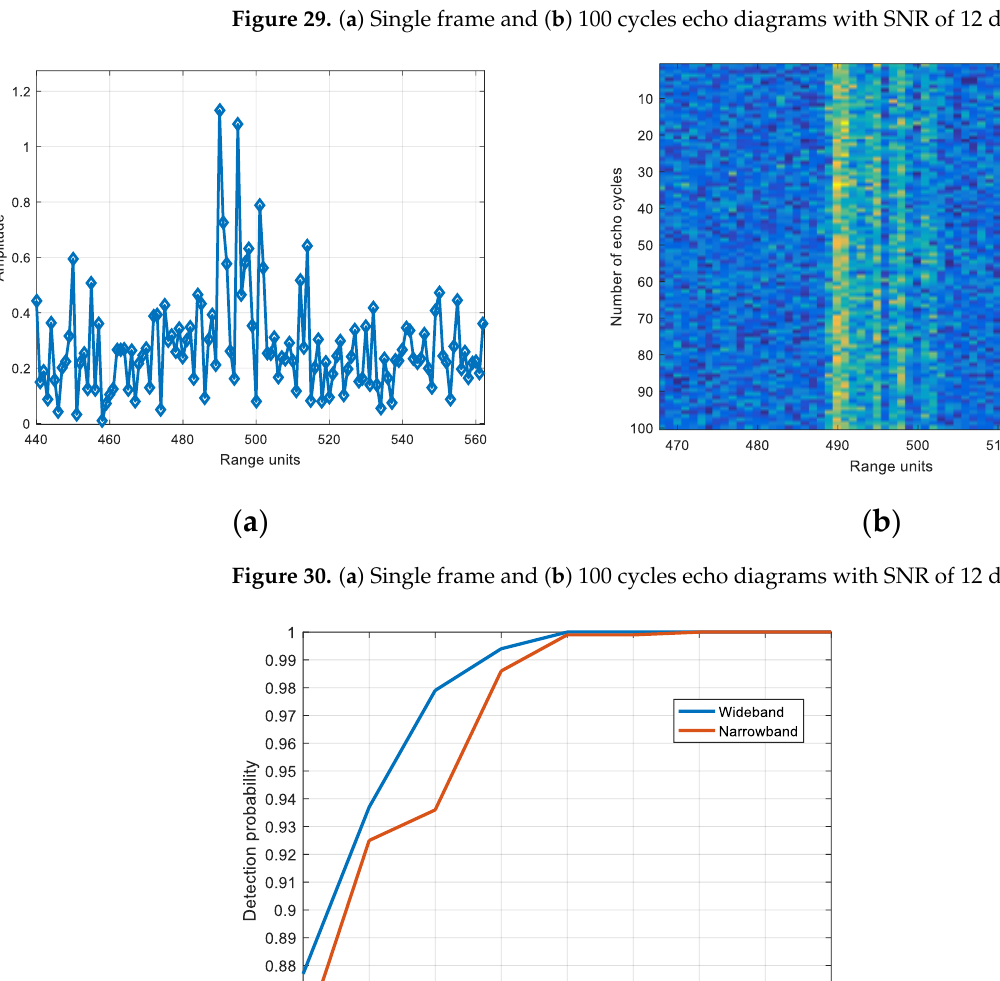
Sensors 2022 , 22 , x FOR PEER REVIEW 22 of 26